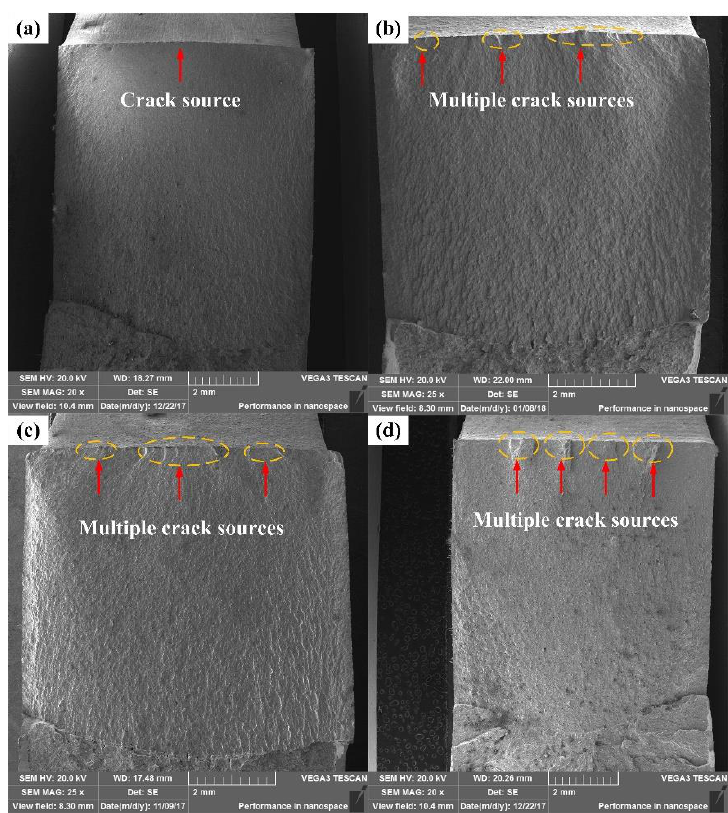
Figure 13. SEM images of fracture surfaces of the notched specimens: ( a ) crack source zone of NP specimen; ( b ) crack source zone of SP1 specimen; ( c ) crack source zone of SP2 specimen; ( d ) crack source zone of SP3 specimen.